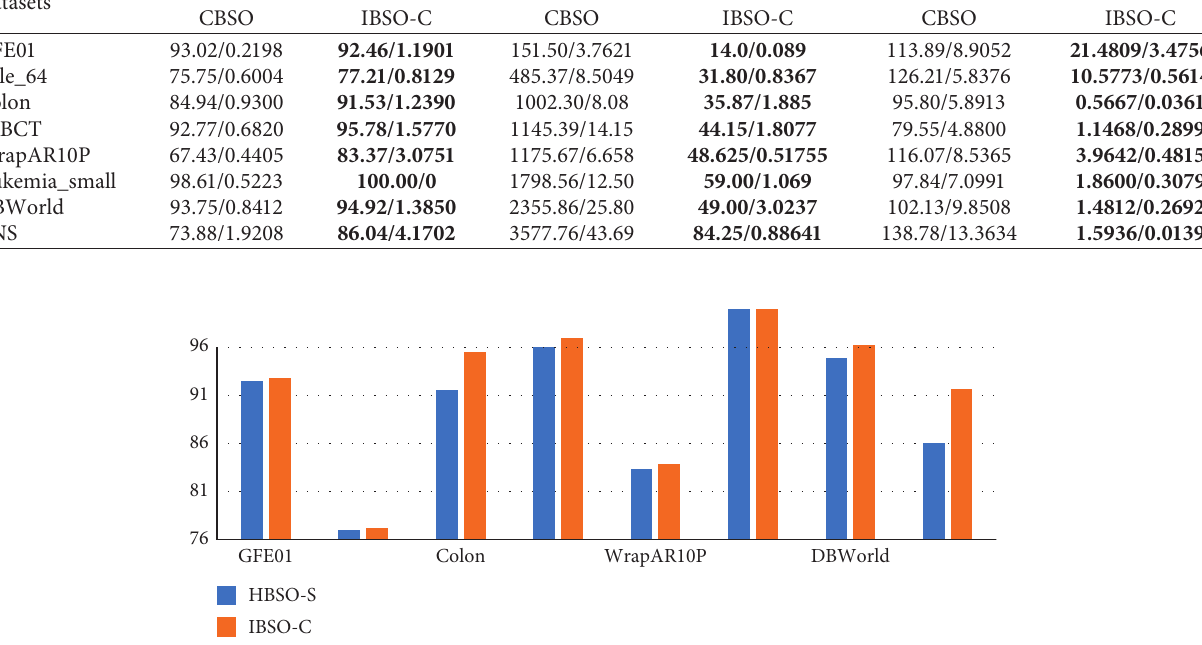
Figure 2: AC values of IBSO-C and